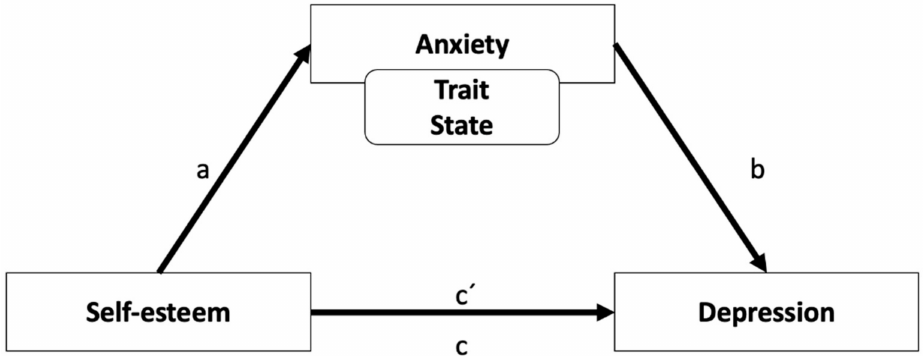
Figure 1. Mediation model under analysis. Note: a, b, c (cid:48) = direct effects; c = total